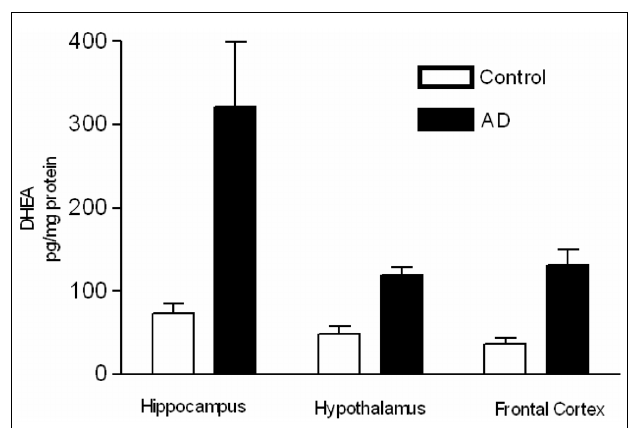
FIGURE 3 | Samples were extracted, and DHEA was purified by HPLC and measured using a specific radioimmunoassay. DHEA levels (pg/mg protein) in brain samples from AD and age-matched control patients with and without treatment with 30mM FeSO 4 (adapted from Brown et al.,